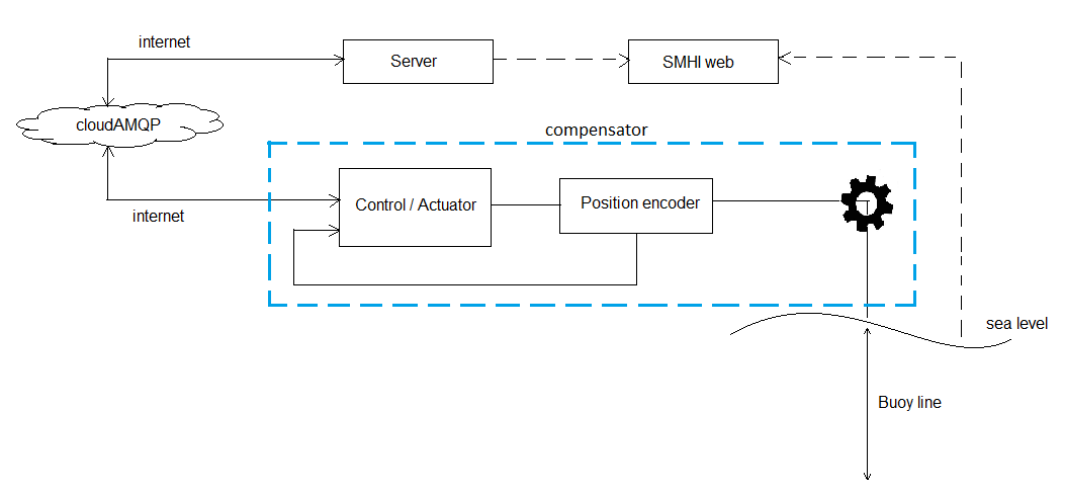
Figure 1. Control flow for the sea level compensation system. The part of the system surrounded by the blue dashed line is shown in Figure 2.